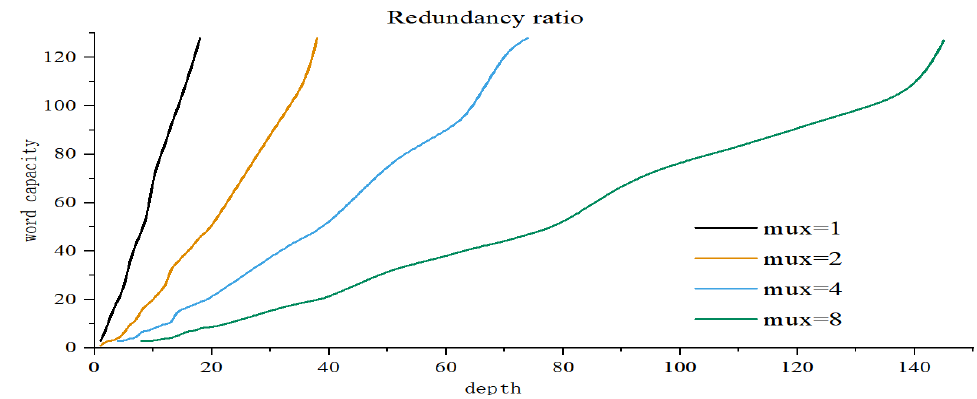
Figure 4. The hardware redundancy ratio of Hamming code and two-dimensional error correction code in the case of mux = 1, 2, 4,